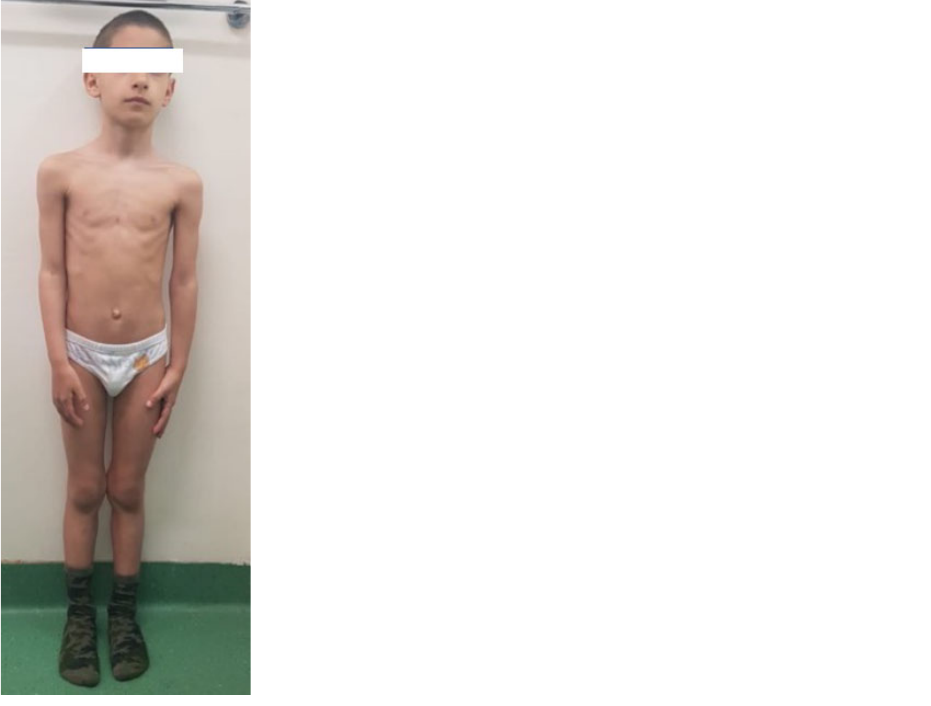
Figure 2. Case report 2: a nine-year-old boy born SGA. Treatment with rGH was started at the age of 5, with a height gain from − 3.6 to − 2.6 SD in 4 years. The clinical exam has excluded a mesomelic short